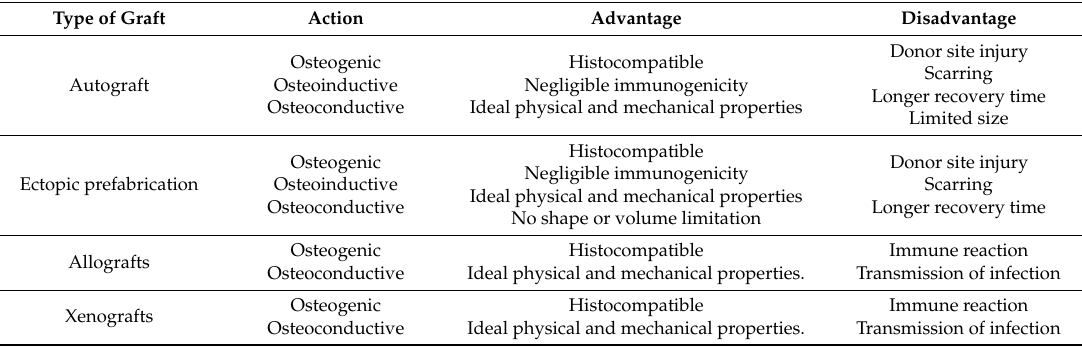
Table 6. Di ff erent types of natural bone